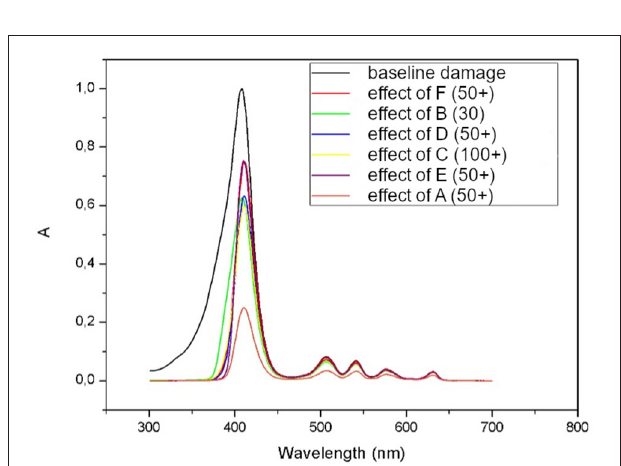
FIGURE 3 | Absorbance (A) spectrum of protoporphyrin IX before (black line represents baseline damage) and after subtracting the action spectrums of each of six tested products (lower red line represents protection of product